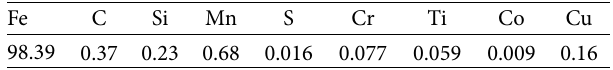
Table 1: Chemical composition of C38 steel (wt.%). Fe